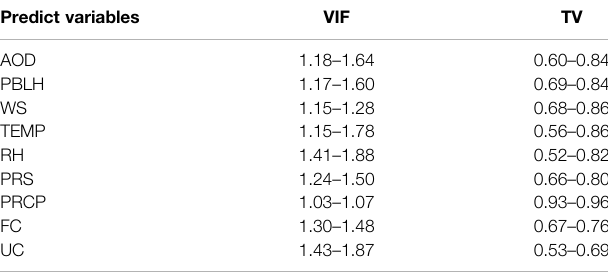
TABLE2| Therangeofvariancein fl ationfactor(VIF)andtolerancevalue(TV)inthe analysis of variable collinearity. Predict variables